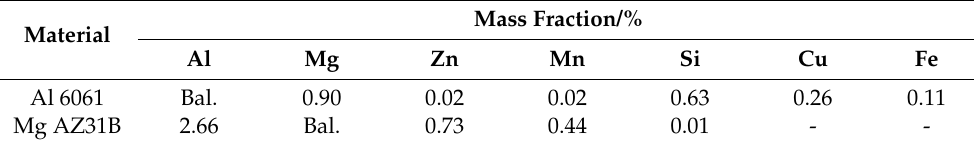
Table 1. Chemical constituents of 6061 Al alloy and AZ31B Mg alloy.